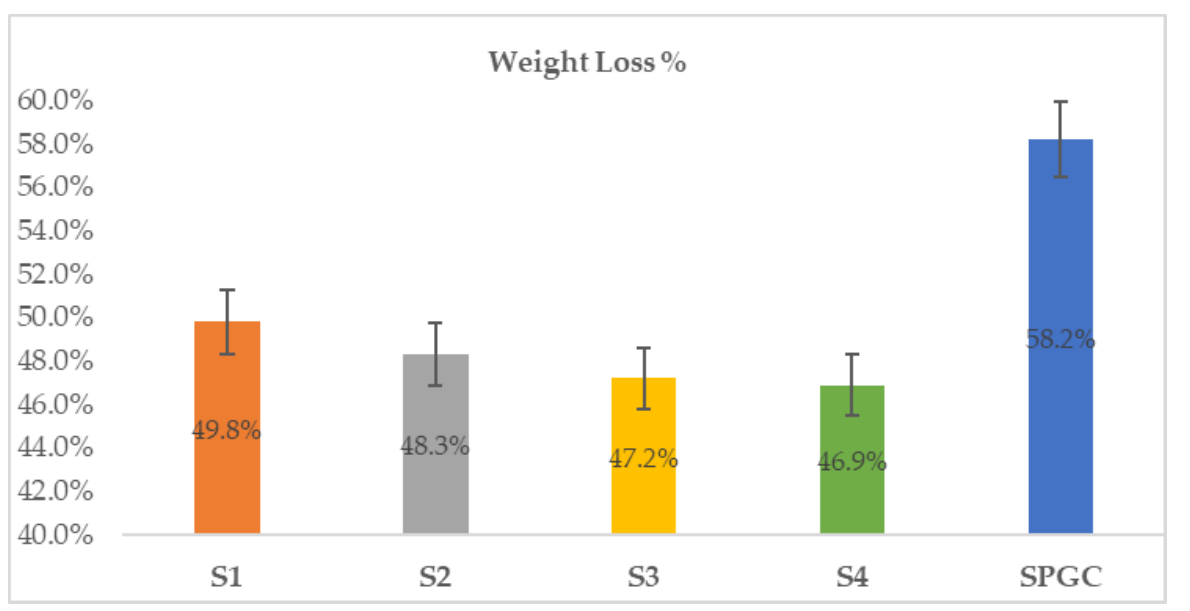
Figure 8. Weight-loss percentage comparison of the starch-based film (SPGC) and the samples (S1–S4) with nZnO .